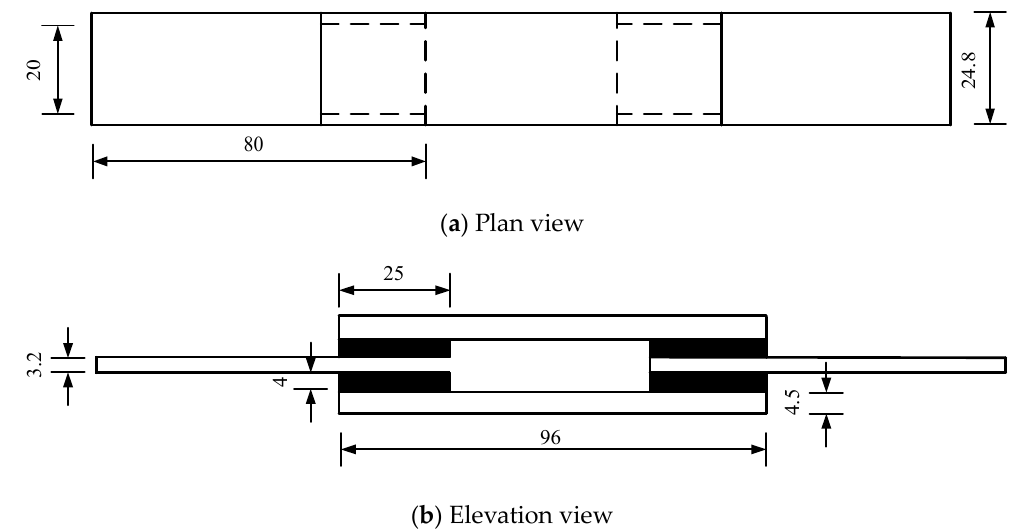
Figure 6. Geometrical sizes of the filled rubber and steel block. (unit: mm).